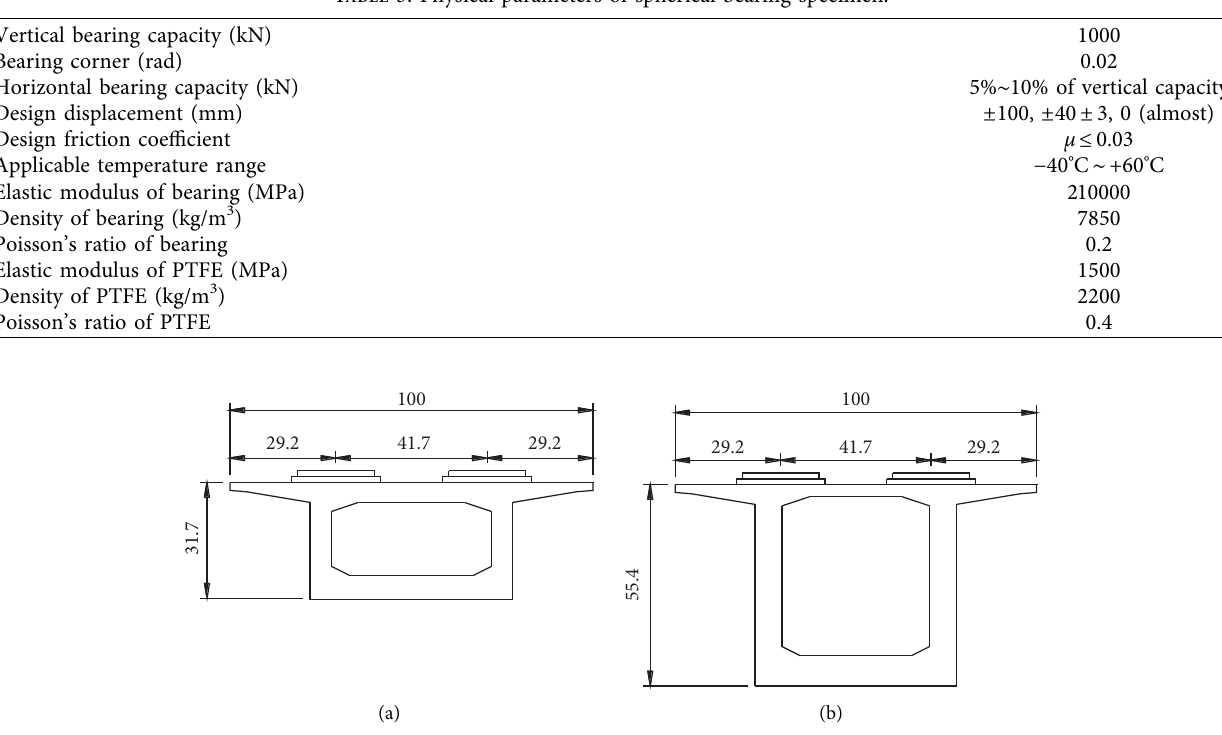
Figure 6: Specimen of girder section for (a) minimum section and (b) maximum section (unit: